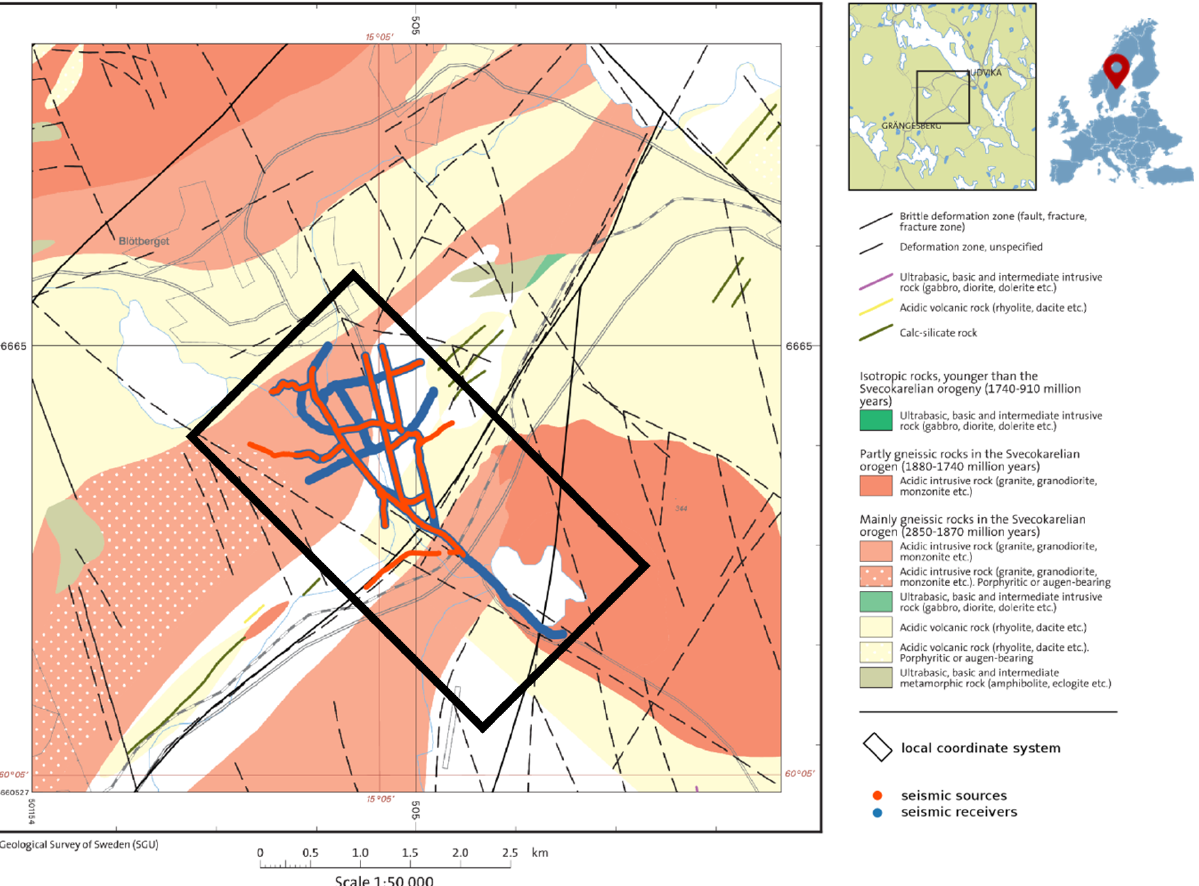
Figure 1. Geological map and survey layout with source (red) and receiver (blue) positions of the 3D survey and the local coordinate system used for first-break travel time tomography and depth imaging (black box). Courtesy of the Geological Survey of